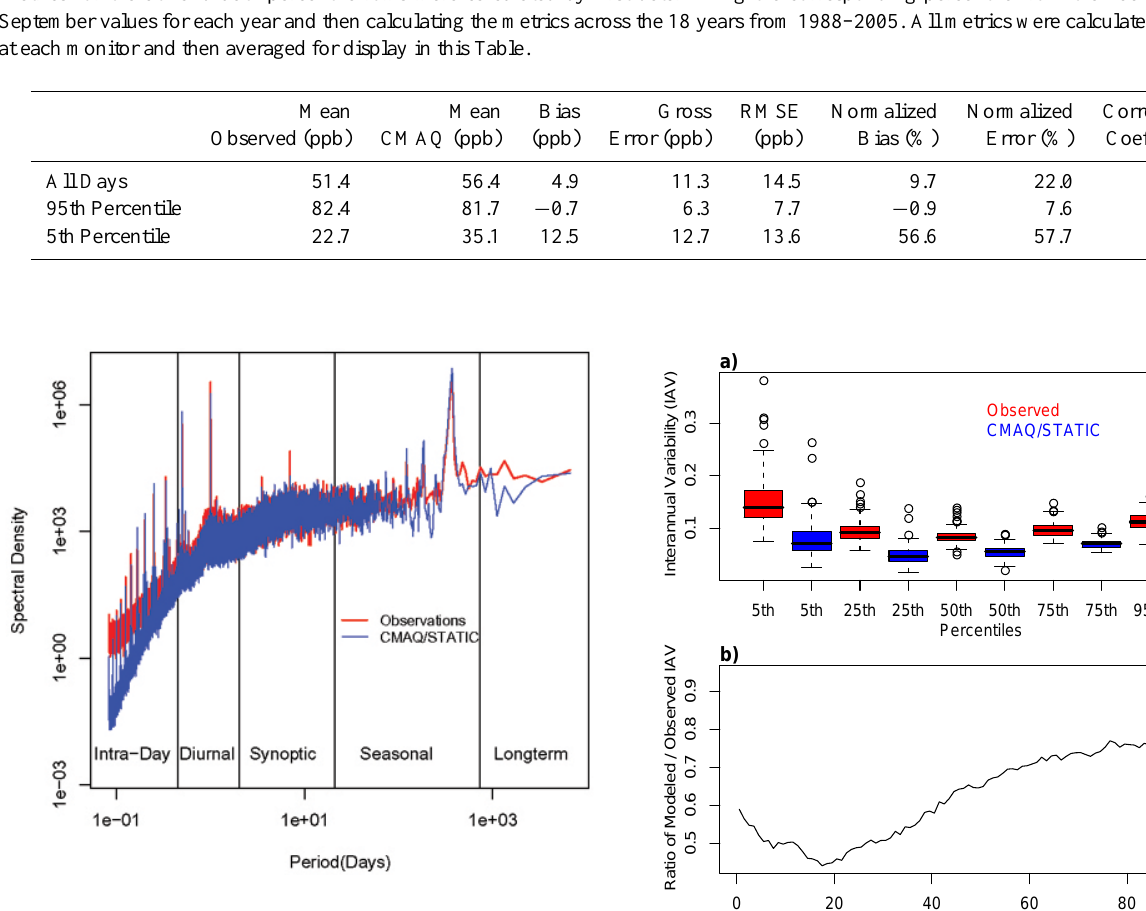
Fig. 3. Power spectra calculated from 18 years of hourly time series of observed and CMAQ/STATIC ozone concentrations. To reduce the noise in the spectra and facilitate the comparison, the spectra were calculated at 19 selected sites and the spectral density at each frequency was then averaged over these sites.